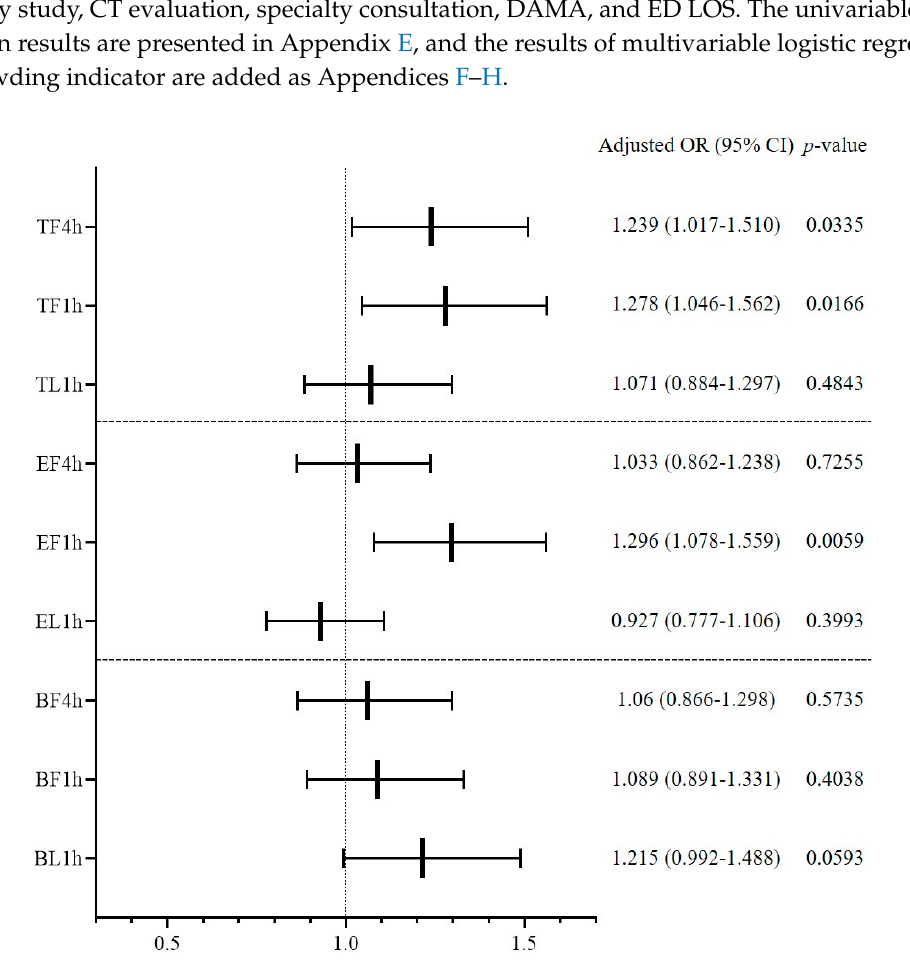
Figure 5. Influence of overcrowding in the emergency department on the occurrence of return visit with admission within 72 h. OR, odds ratio; CI, confidence interval; TF4h, total patients during first 4 h; TF1h, total patients during first 1 h; TL1h, total patients during last 1 h; EF4h, evaluating patients during first 4 h; EF1h, evaluating patients during first 1 h; EL1h, evaluating patients during last 1 h; BF4h, boarding patients during first 4 h; BF1h, boarding patients during first 1 h; BL1h, boarding patients during last 1 h.